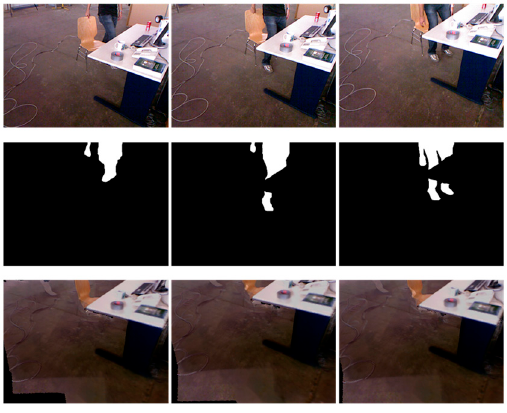
Figure 5. The detection of dynamic factors using the geometric residual method may suffer from incomplete detection of the same dynamic object. The basic idea of the region-growing method is to merge pixel points with similar properties; therefore, the introduction of region growing enables the complete detection of dynamic objects and their segmentation. Region growing is performed based on point attribute similarity within the detected dynamic object region, where the point data lack a clear neighborhood relation. Frames 1125, 1136, and 1148 were selected to display the dynamic changes. Figure 5 shows a person walking to the table and preparing to sit down. The first row shows the original frames. The original image was aligned to the TSDF model using the method described in Section 2.1, and the dynamic factors from the image were detected and filtered out using the geometric residual method. The second row shows the mask of the dynamic factors. Finally, the images is are restored and the dynamic factors are removed. The third row shows the images after restoration of the background.